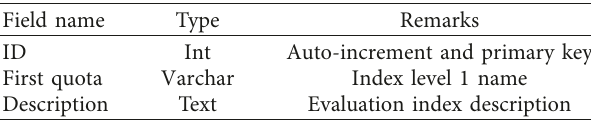
Table 7: Primary indicators of achievement evaluation.